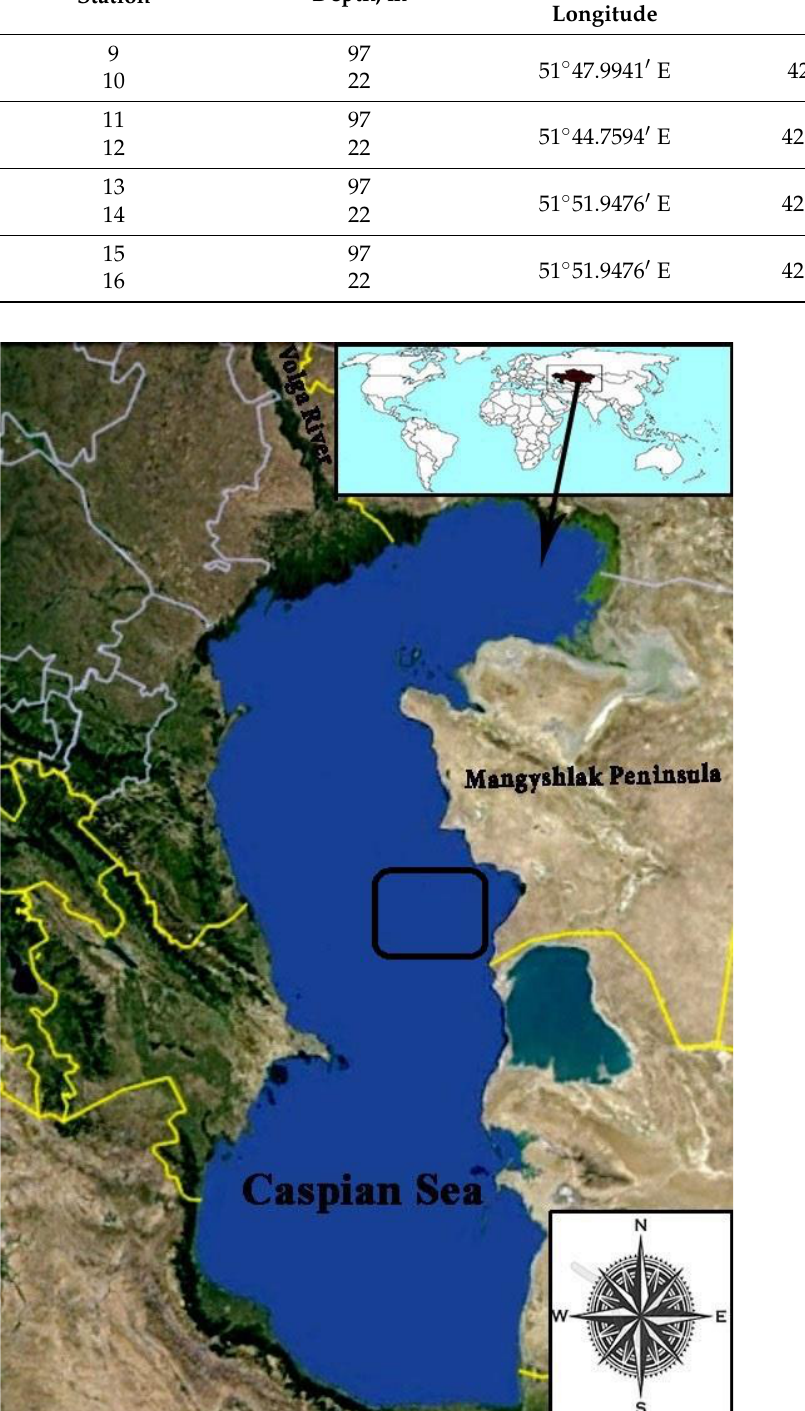
Figure 1. Map-scheme of the location of the sampling station (black square) in the middle part of the Caspian Sea, May 2021.